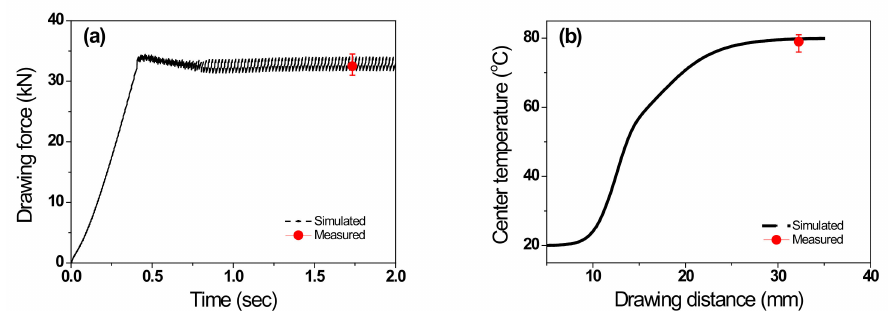
Figure 5. Comparison of measured and simulated ( a ) drawing force and ( b ) center temperature of the wire during the conventional wire drawing process used in this